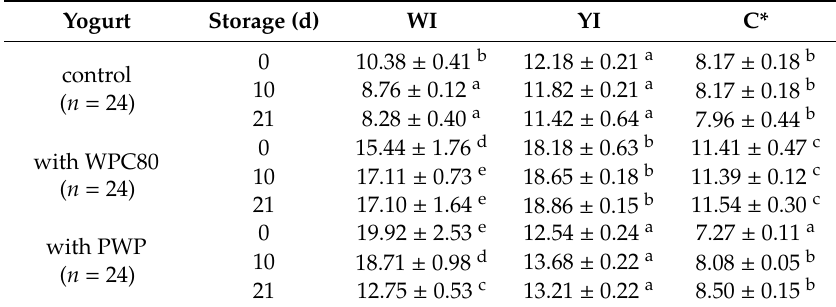
Table 5. Assessment of the color of yogurt with increased whey proteins content, including whey proteins after the polymerization